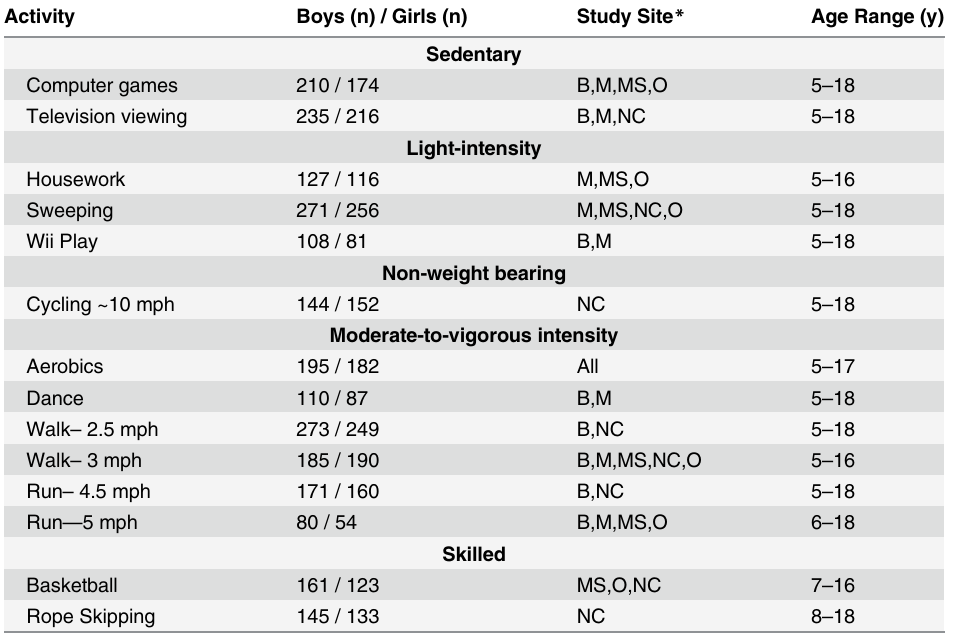
Table 1. Activity, sample size, study-site contributing data, and age ranges for each of the activities examined in this